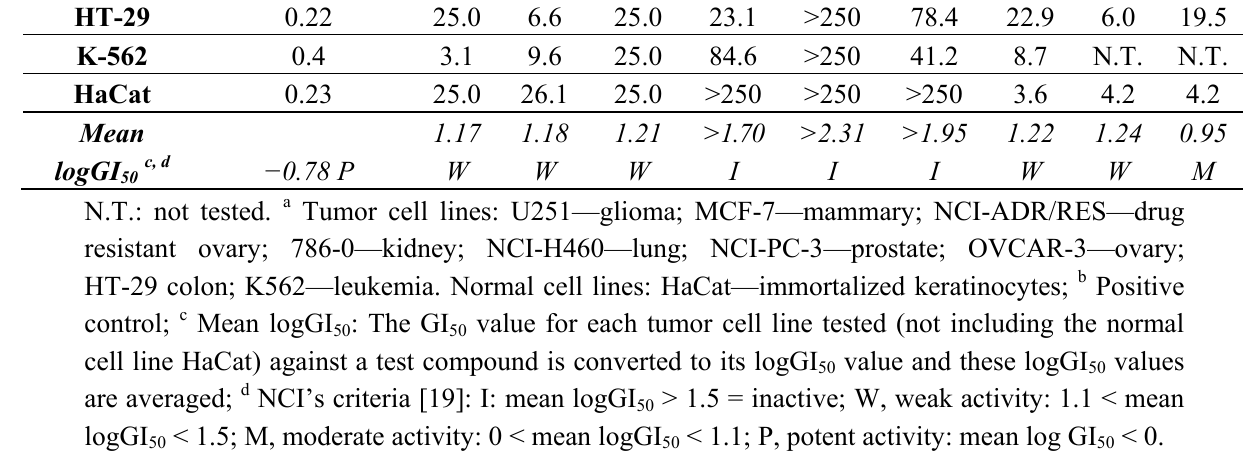
Table 3. Antiproliferative activity (GI Cell lines